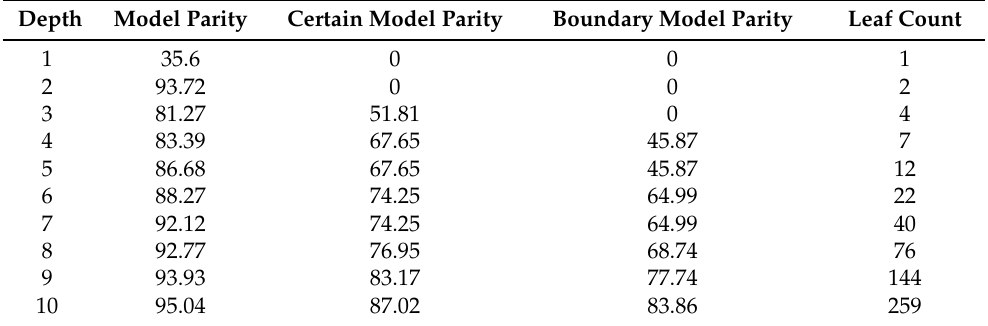
Table 4. Evaluation of the interpretable models for the Abalone dataset generated by MTRE-PAN at depths ranging from 1 to 10.